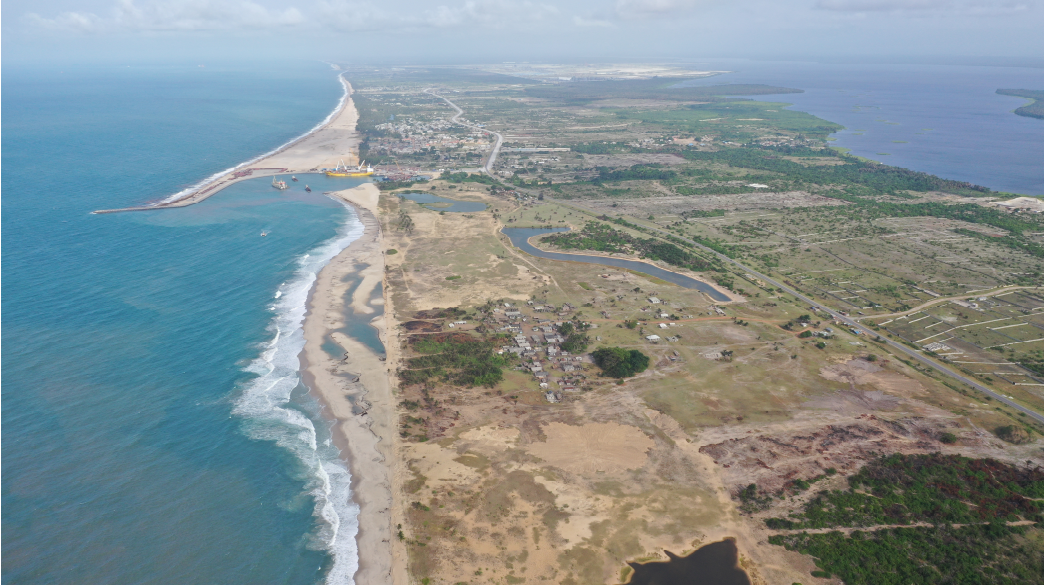
Figure 1. Westward looking aerial photo of the Sandbar Breakwater including the sand engine. Image courtesy of CDR International B.V.